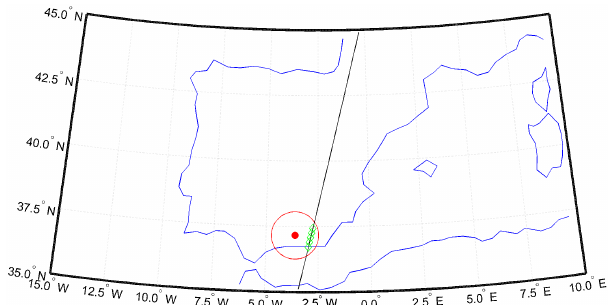
Figure 3. CALIOP overpass over Granada station on 7 July 2011 at 02:20UTC at 67km distance from the station. The red circle shows 100km distance from EARLINET station (the red dot in the centre). The black line represents the CALIOP ground track, while the green empty diamonds represent five CALIOP profiles that were averaged and compared to EARLINET